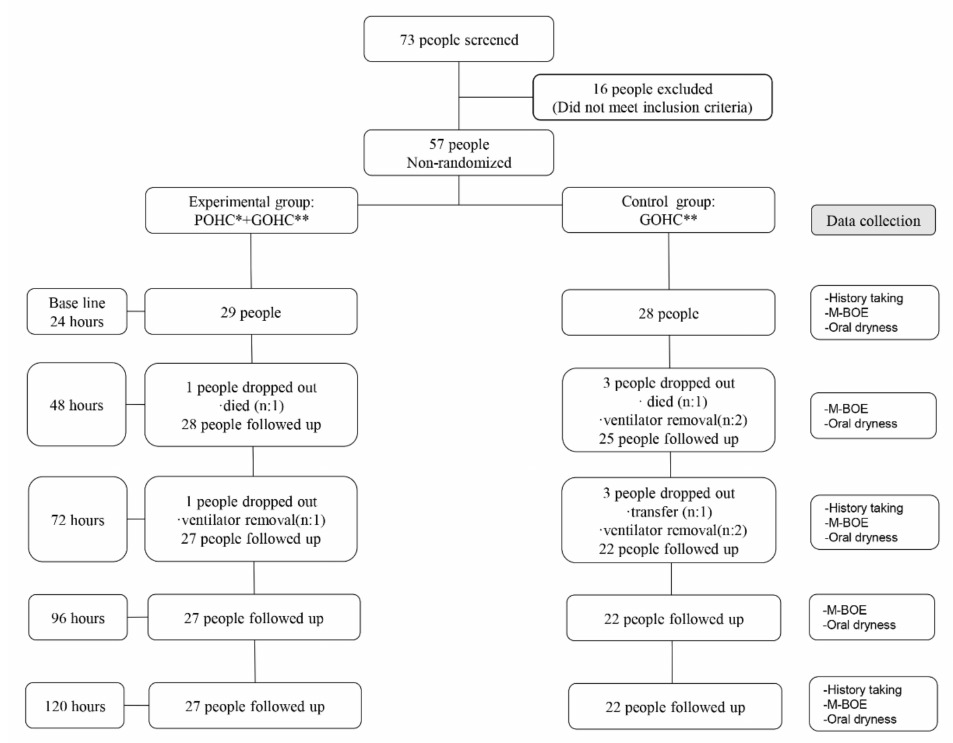
Figure 1. Study process.* POHC = Professional oral hygiene care by dental hygienist; ** GOHC = General oral hygiene care by